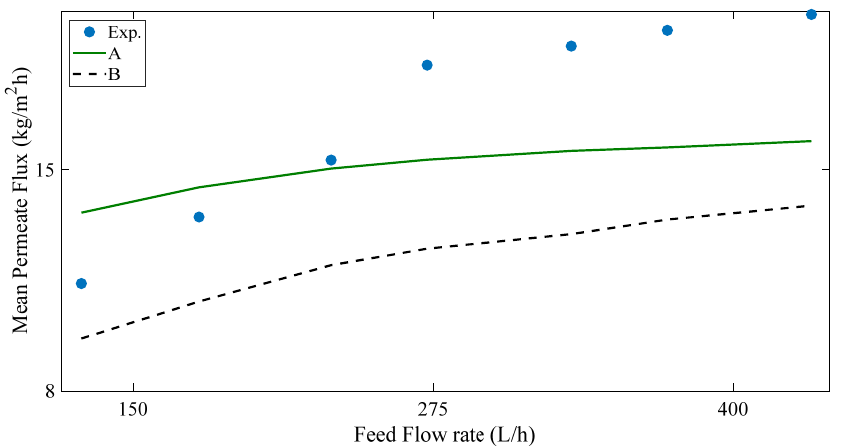
Figure 7. The permeate flux as a function of feed flow rate with experimental and analytical (( A ): with spacer; ( B ): without spacer) results.